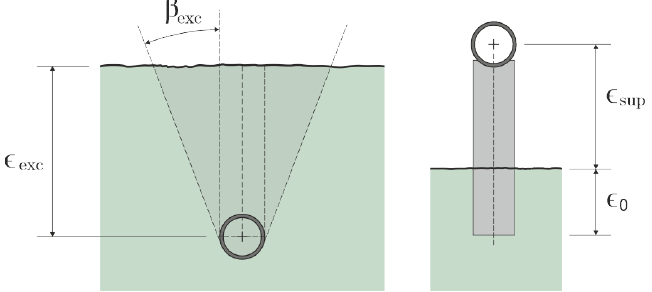
Figure 6. Scheme of the model proposed for the excavations ( left ) and supports ( right